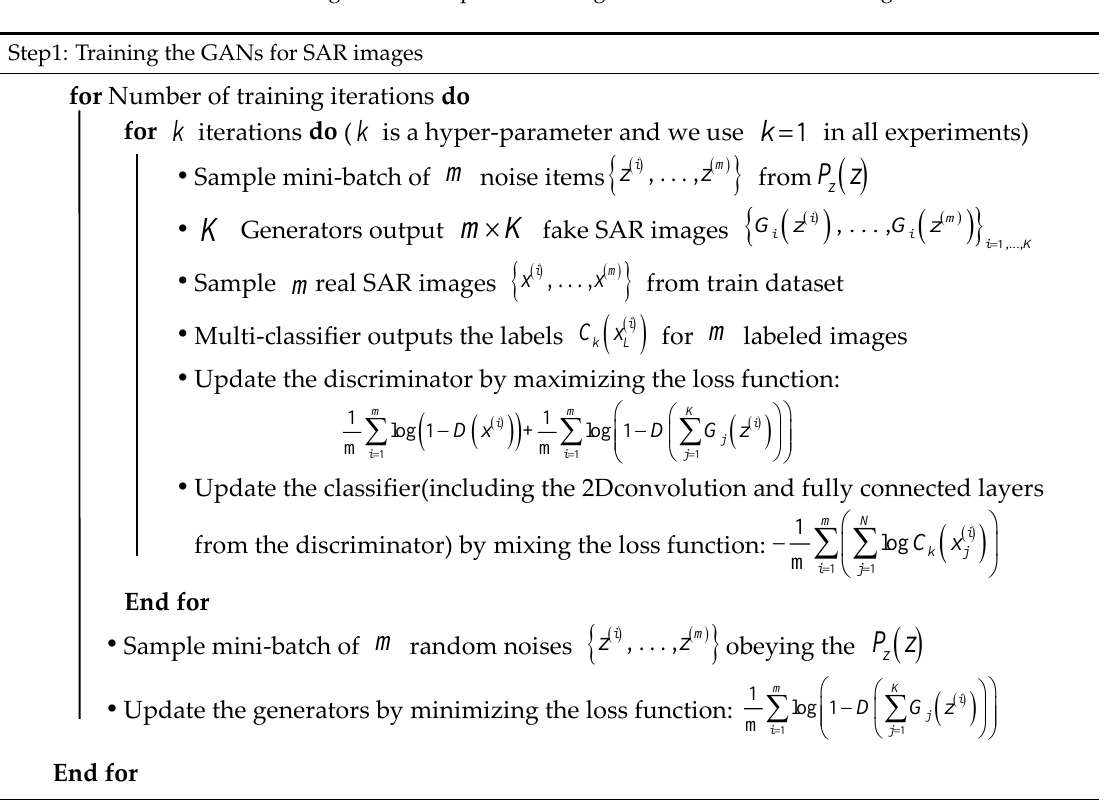
Table 1. Training the semi-supervised recognition network for SAR images. Table1. Training the semi-supervised recognition network for SAR